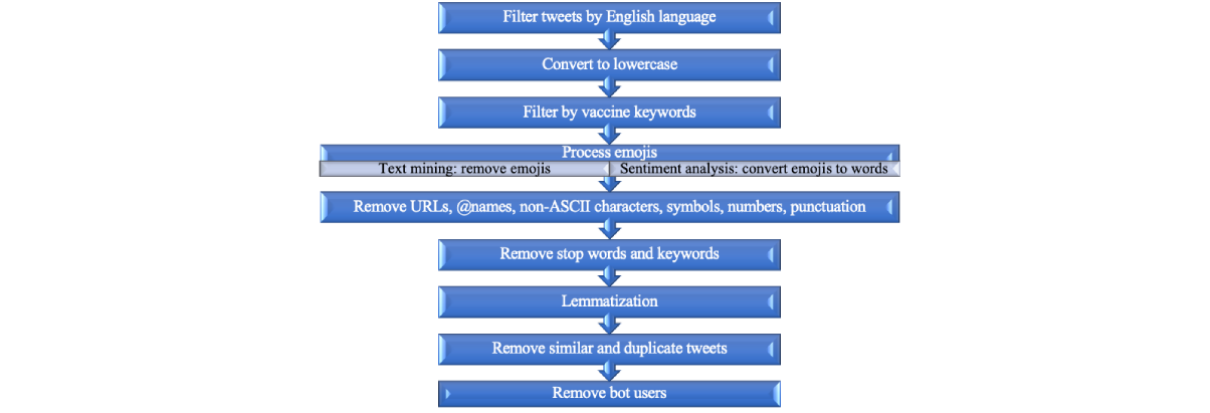
Figure 1. Data preprocessing procedure. ASCII: American Standard Code for Information